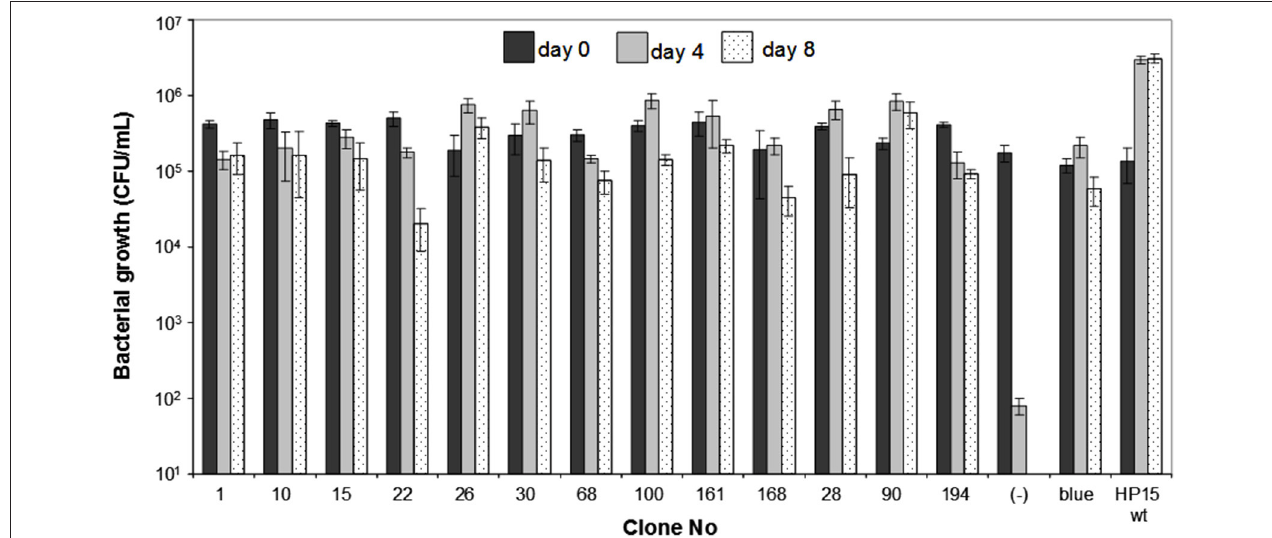
FIGURE 3 | Growth of individual clones of M. adhaerens HP15 1 pyrB carrying potential in co-culture induced promoters and T. weissflogii . Wild-type and a blue colored mutant were used as a positive control. 1 pyrB HP15 (pITM3_pyrB) was used as a negative control.